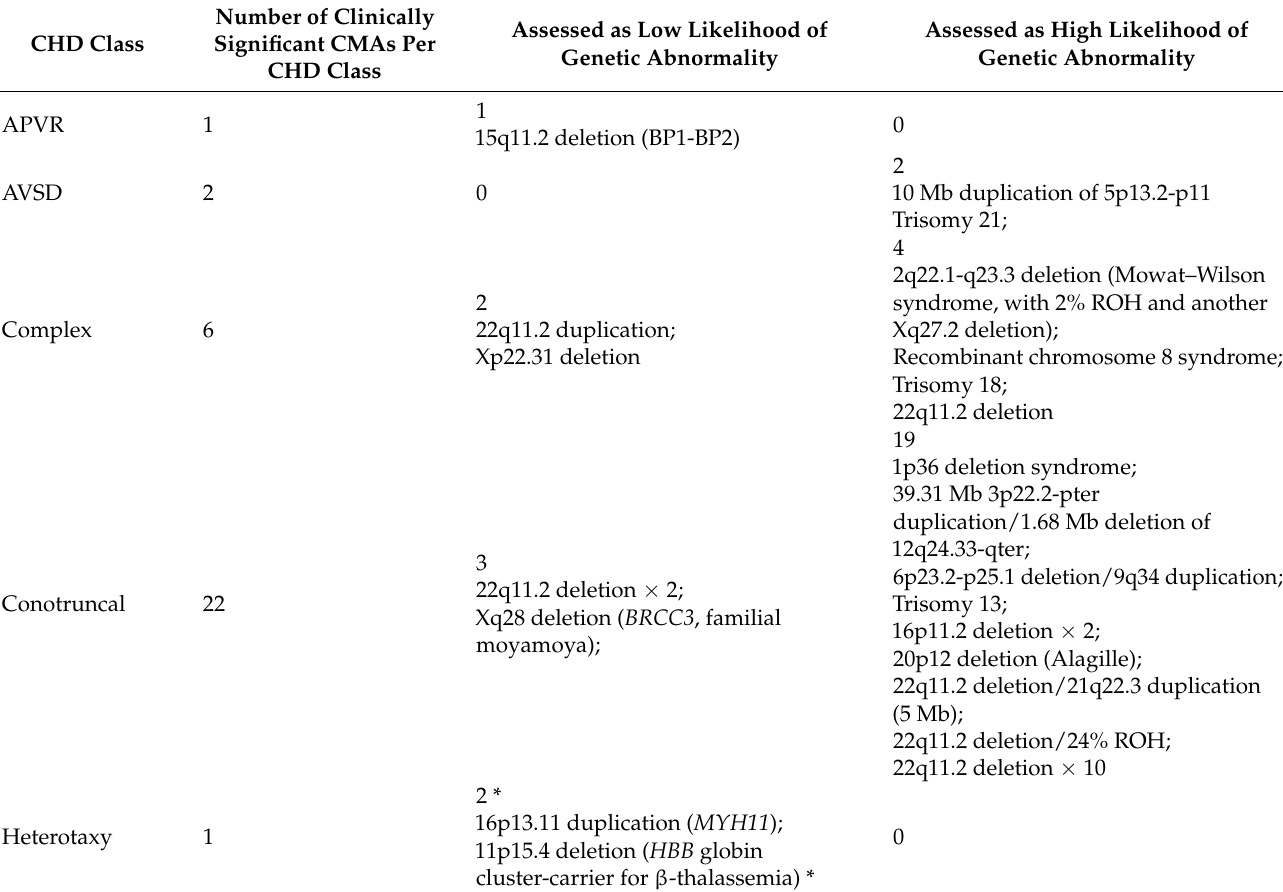
Table 4. Geneticists’ a priori assessment of the likelihood of genetic